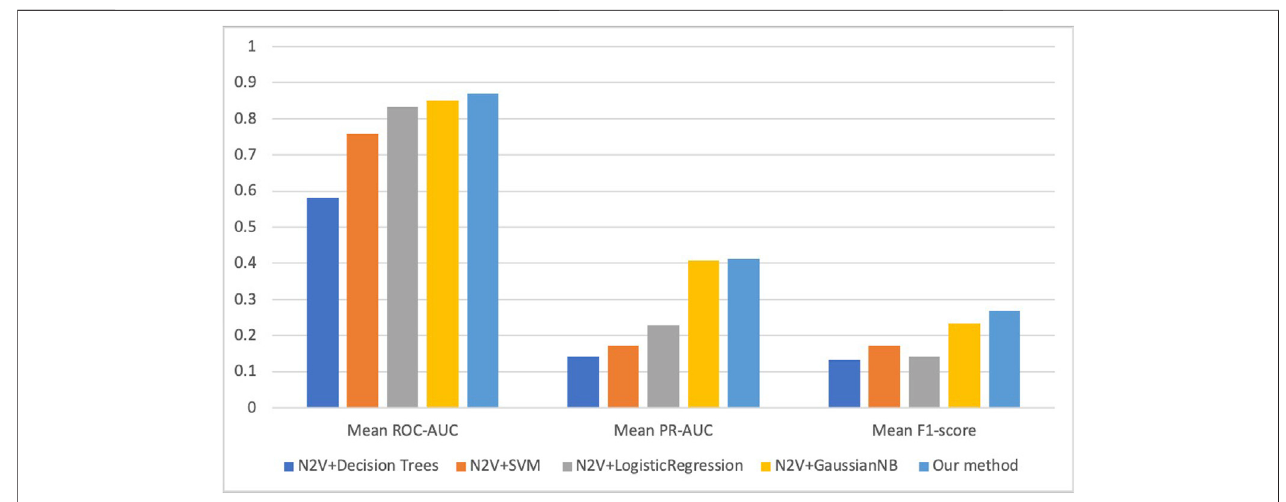
FIGURE3| TheaverageROC-AUC,PR-AUC,andF1-scoreof fi vemethodsonmiRNA-MSassociationpredictiontask.N2VrepresentsNode2Vecwhichextracts miRNA features based on two miRNA networks.